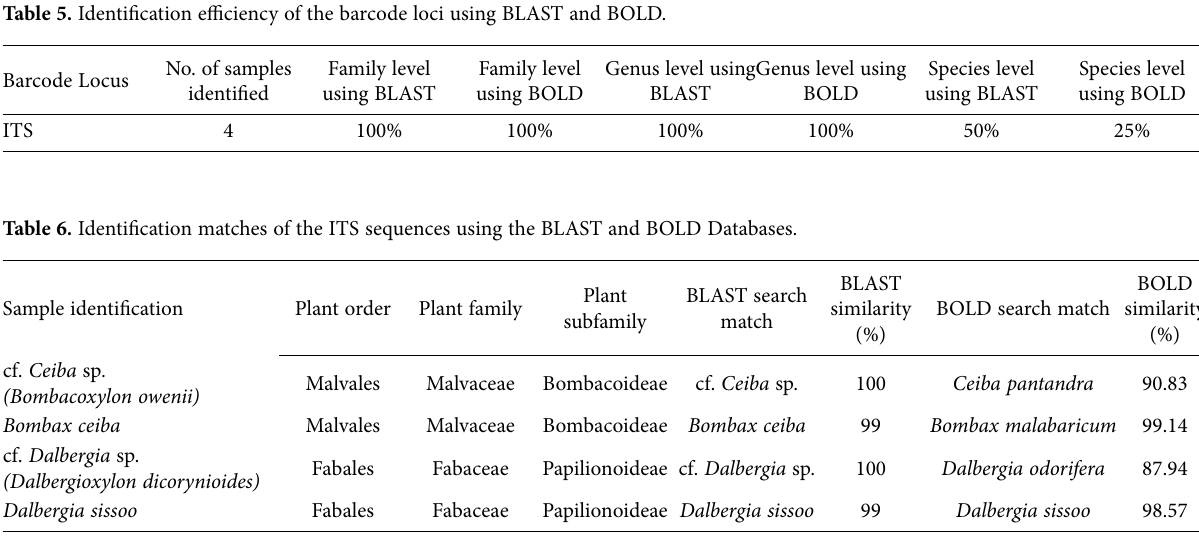
Table 5. Identification efficiency of the barcode loci using BLAST and BOLD. Barcode Locus